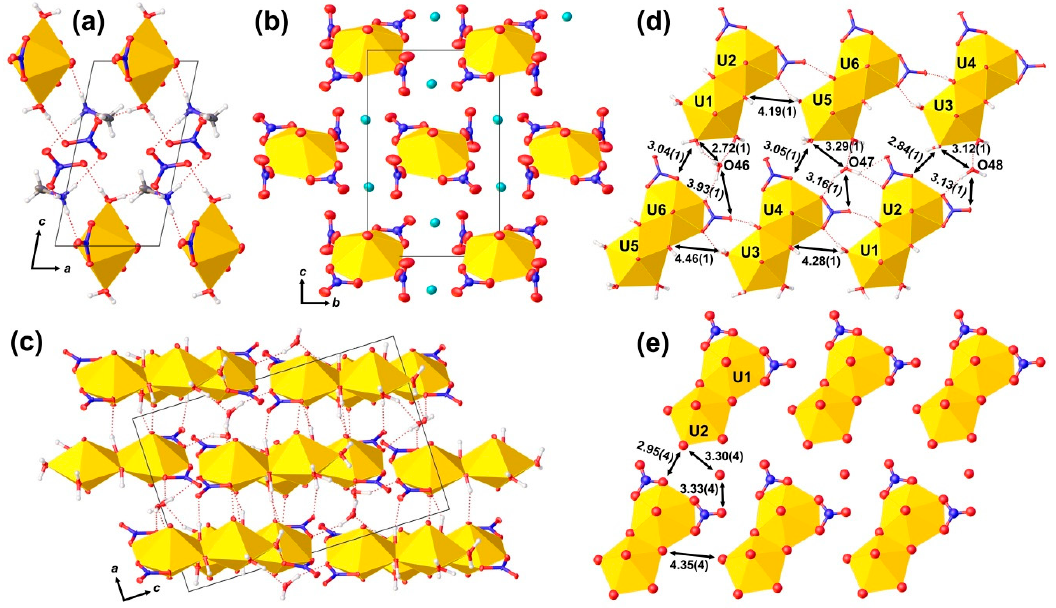
Figure 4. Crystal structures of 4 ( a ), 5 ( b ) and 6 ( c ); differences in the uranyl nitrate cluster arrangement in the structures of 6 ( d ) and α -[(UO 2 ) 2 (OH) 2 (NO 3 ) 2 (H 2 O) 3 ](H 2 O) [16] ( e ). Legend: see Figures 2 and 3; dashed red lines = H-bonds.